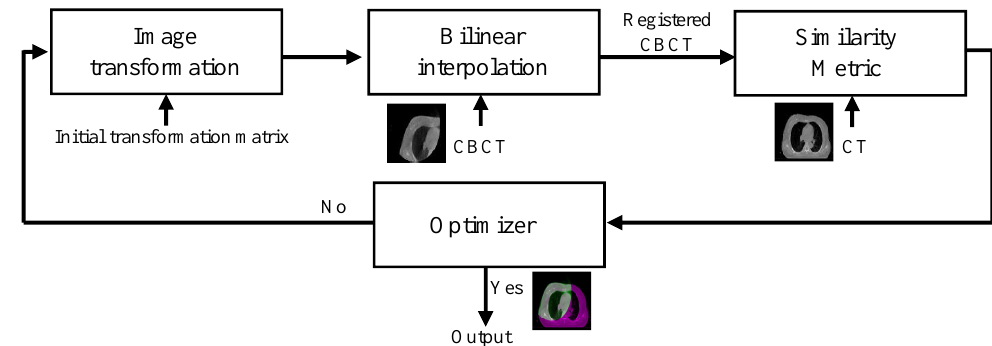
Figure 5. Flowchart of the intensity-based registration method.